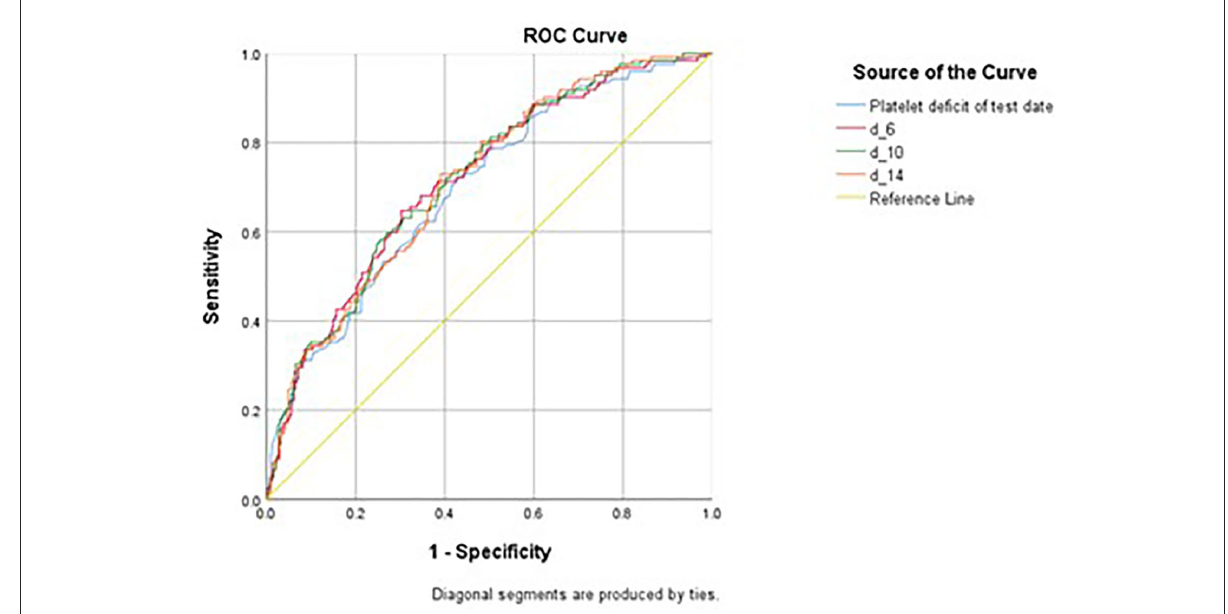
FIGURE2 Receiver Operating Curve (ROC) of various measurements in predicting pulmonary hemorrhage in patients with SM infection. Platelet deficit of the test date, the deficit of the platelet count from the lowest normal limit on the test date (150 × 10 3 / µ L - platelet count). d_6, daily average of d-index 3 days before and after the sputum test date, d_10, daily average of d-index 5 days before and after the sputum test date, d_14, daily average of d-index 7 days before and after the sputum test date.